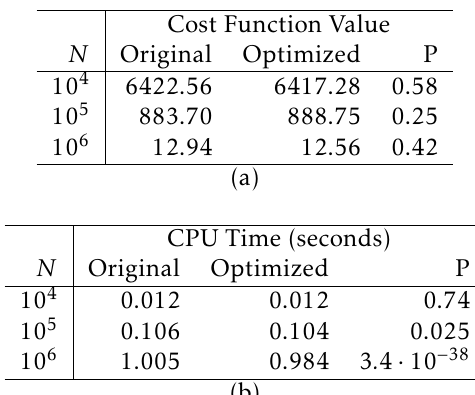
Table 1. OneMax: (a) optimization cost function, and (b) CPU time. Results are averages of 100 runs, and the P column shows t-test P-values.